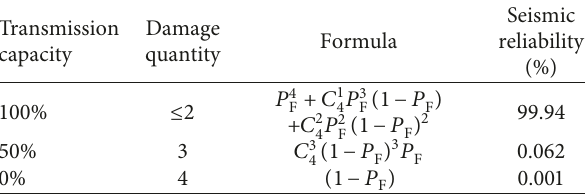
Table 4: Seismic reliability of the AC field subsystem of the UHVDC transmission system.